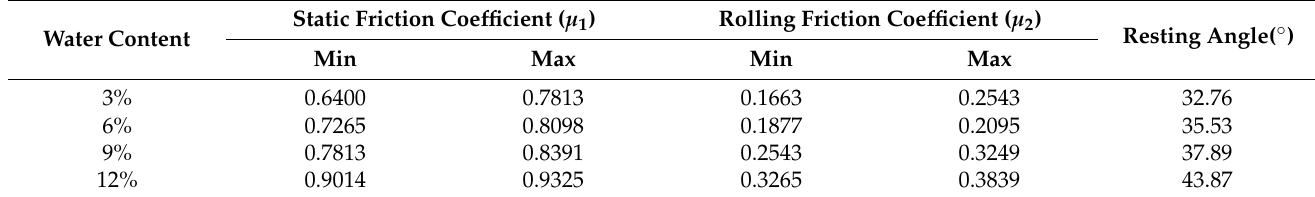
Table 1. Friction coefficient and rest angle of soil with different water content.